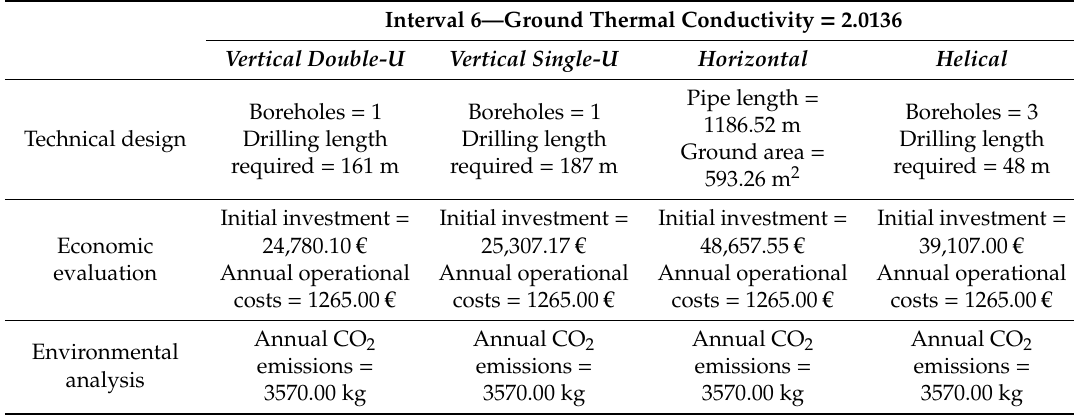
Table 10. Design provided by GES-CAL software for the geothermal system under study, interval 6.